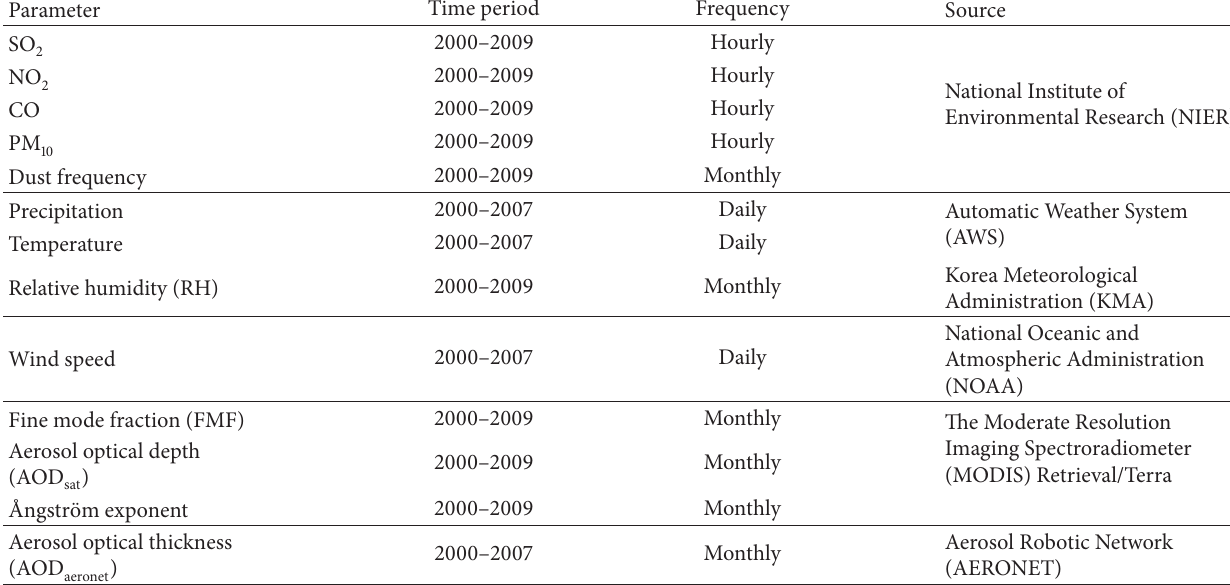
Table 1: The characteristics and source of data used in this